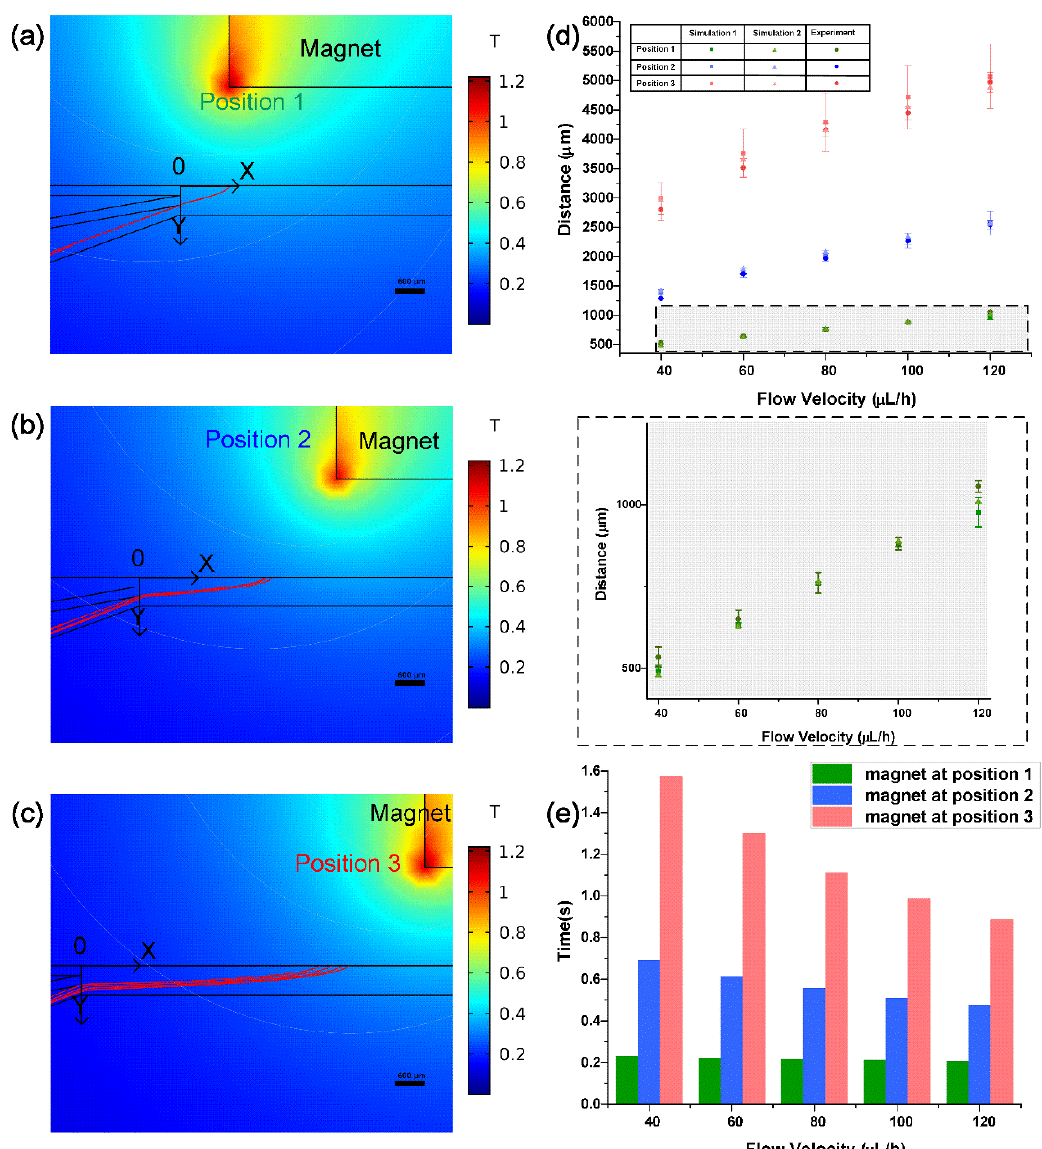
Figure 2. Trajectories of beads with a 1 cm × 1 cm × 2 cm external permanent magnet at di ff erent positions in simulation 1(a–c), bar = 600 µ m. All the beads ( a ), part of the beads ( b ), and few beads ( c ) deflected to the wall of the branched channel with u fl = 120 uL / h; (a) x = 1 mm, (b) x = 4 mm, and (c) x = 7 mm. ( d ) Distance between final position of beads at di ff erent flow velocities and magnet positions in simulation and experiment. ( e ) The time of beads crossed the main channel with di ff erent conditions in simulation 1.